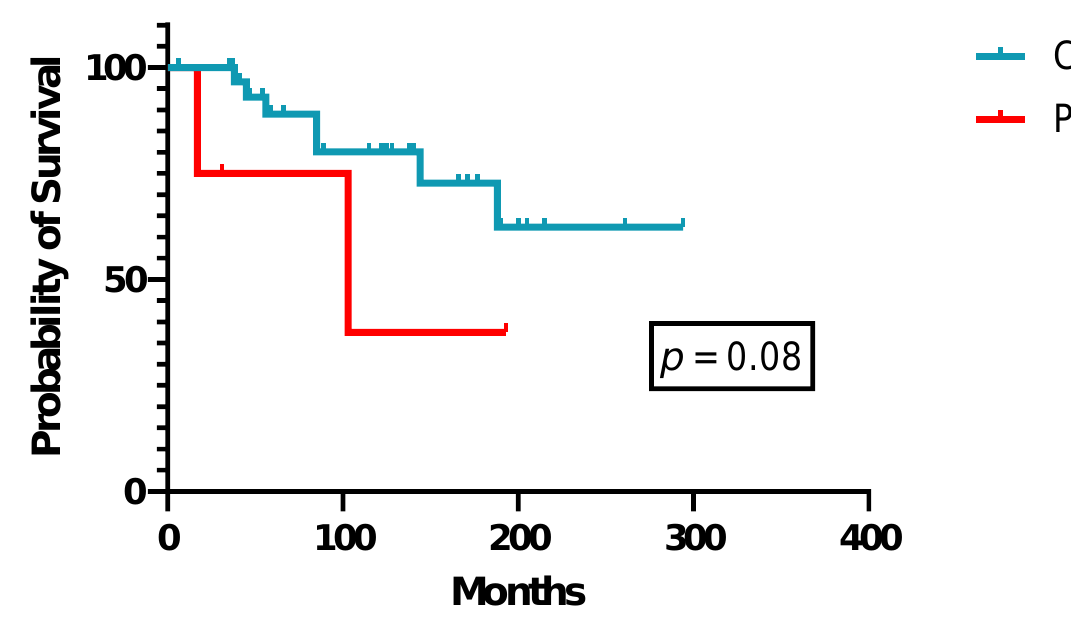
Figure 3. Progression-free survival after first-line 2-CdA according to response ( n = 42).